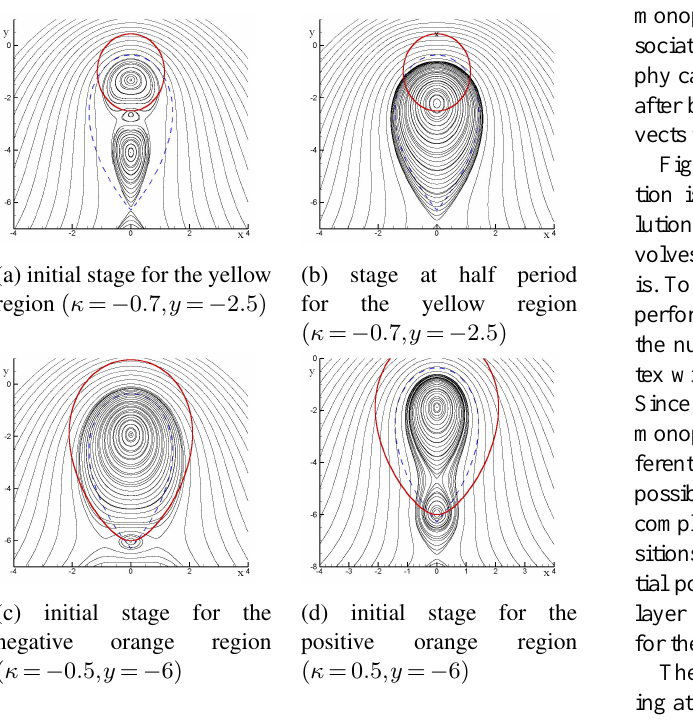
Fig. 9. Streamlines of the flow in the middle-layer monopole case. Fig. 9: Stream-lines of the flow in the middle-layer monopole The red curve corresponds to the monopole motion trajectory. The case. Red curve corresponds to the monopole motion tra- dashed blue curve is the topographic vortex unperturbed jectory. Dashed blue curve is the topographic vortex unper- Fig. 9: Stream-lines of the flow in the middle-layer monopole turbed separatrix. case. Red curve corresponds to the monopole motion tra- jectory. Dashed blue curve is the topographic vortex unper- turbed separatrix.